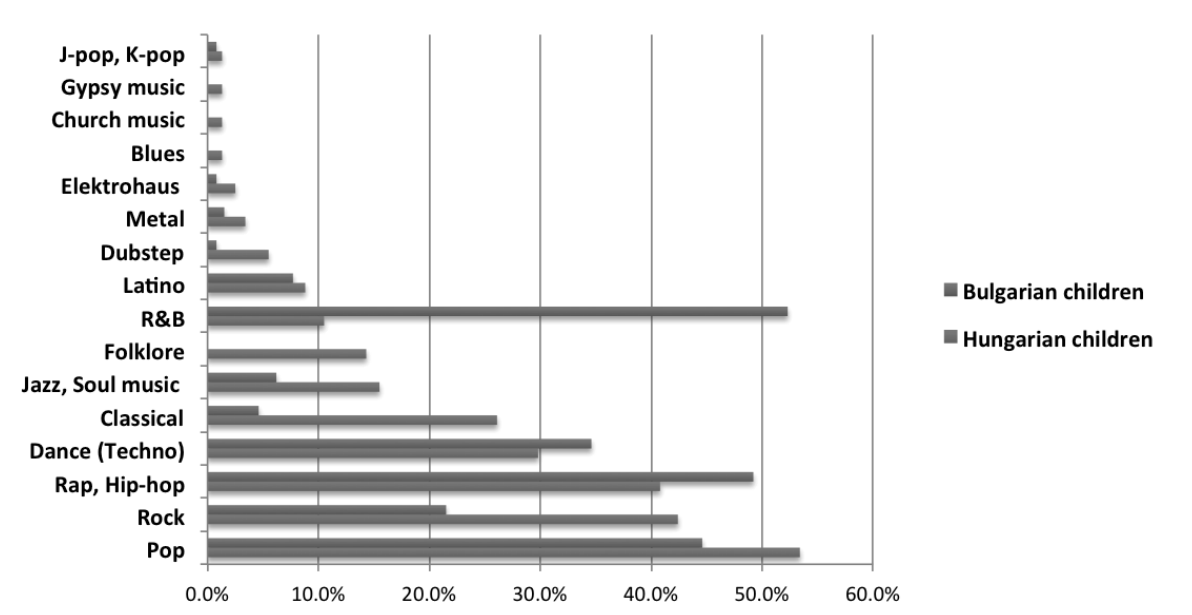
Fig. 4. Comparison of music style choices between Hungarian and Bulgarian